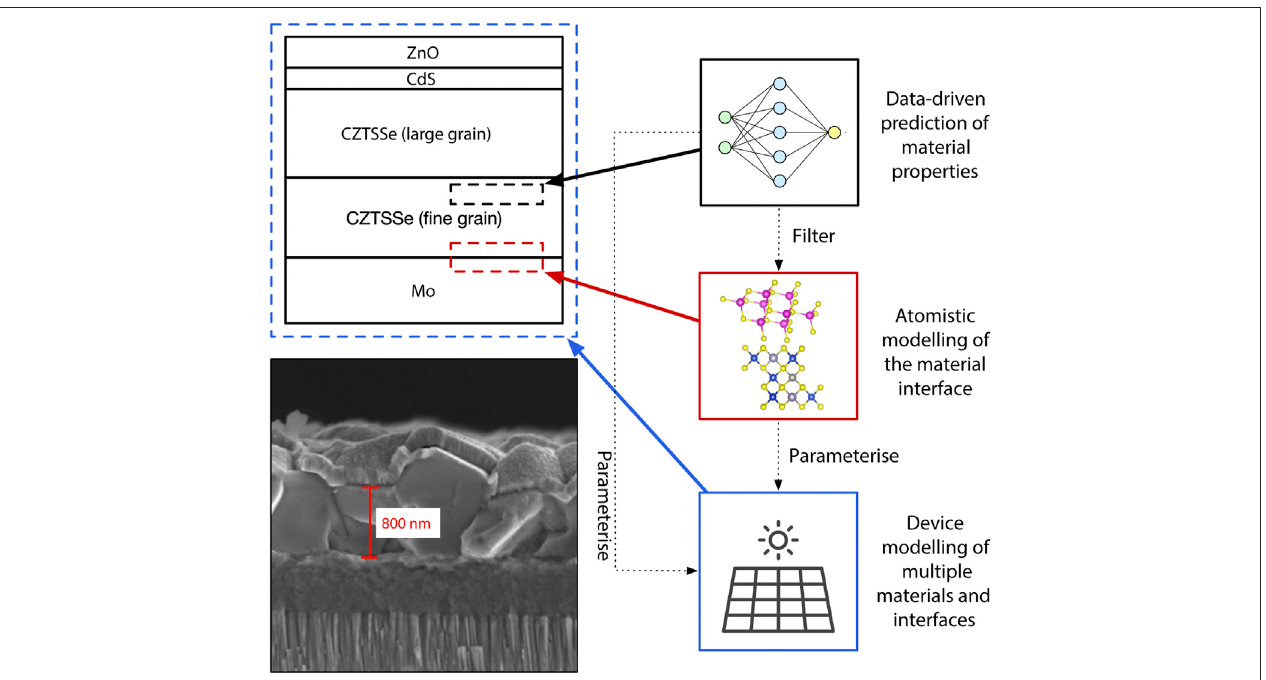
FIGURE 1 | Image and schematic outlining the multi-layered structure of a typical Cu 2 ZnSn(S,Se) 4 (CZTSSe) solar cell and the various approaches to interface modelling.ThebottomleftimageisaScanningElectronMicroscope(SEM) imageofaCZTSSethin fi lmphotovoltaicdevicefabricated fromnanoparticleinks.Thelength scaleisindicatedinred.Thetopleftisaschematicofthesamedevice,shownforclarity.Thethreeboxesontherightoutlinethreecomplimentaryapproachestointerface modelling: 1) (black boxes) data-driven approaches for predicting the properties of a single interface material; 2) (red boxes) atomistic modelling of the interface between two materials; and 3) (blue boxes) continuum modelling of the complete device, including multiple materials and interfaces. The dotted arrows indicate how thesemodelsrelatetooneanother:loweraccuracydata-drivenpredictionscanbeusedasainitial fi lteringstepbeforehigheraccuracyatomisticmodelsareapplied,and both of these approaches can be used to parameterise device models. The solar cell icon is a resource downloaded with permission from Flaticon.com.